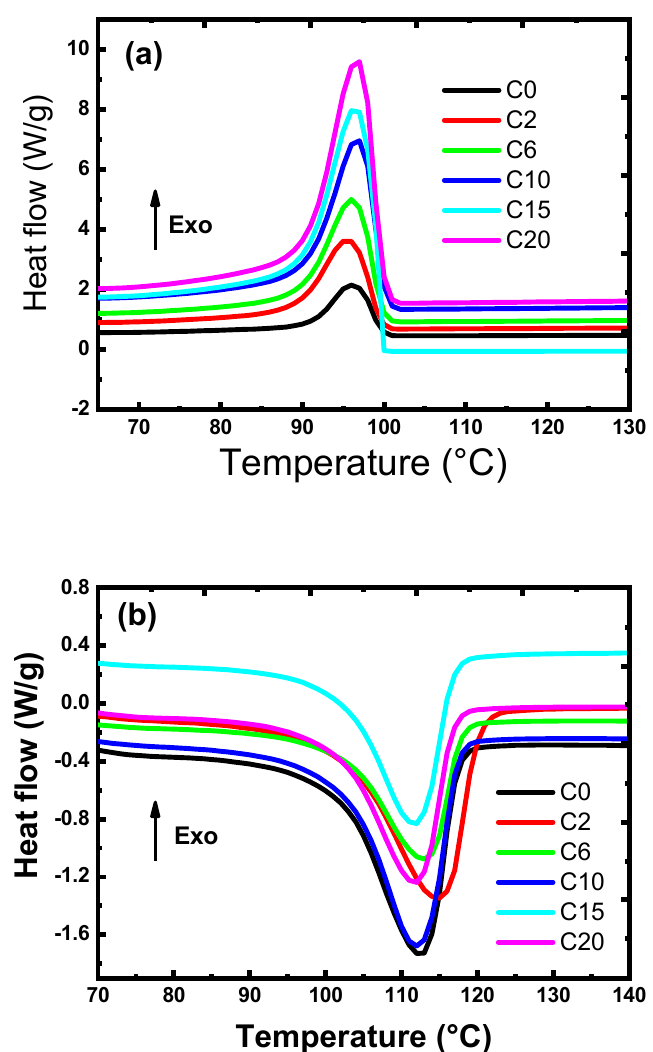
Figure 6. Differential scanning calorimetry (DSC) curves of LDPE/HIPS/TWP polymer composites: ( a ) cooling curve showing the crystallization peak; and ( b ) heating curve showing the melting peak. Table 4. Crystallization, melting temperatures and enthalpies, and degree of crystallinity, and electrical resistivity of LDPE/HIPS blend and LDPE/HIPS/TWP composites. The standard deviation is based on at least three measurements.